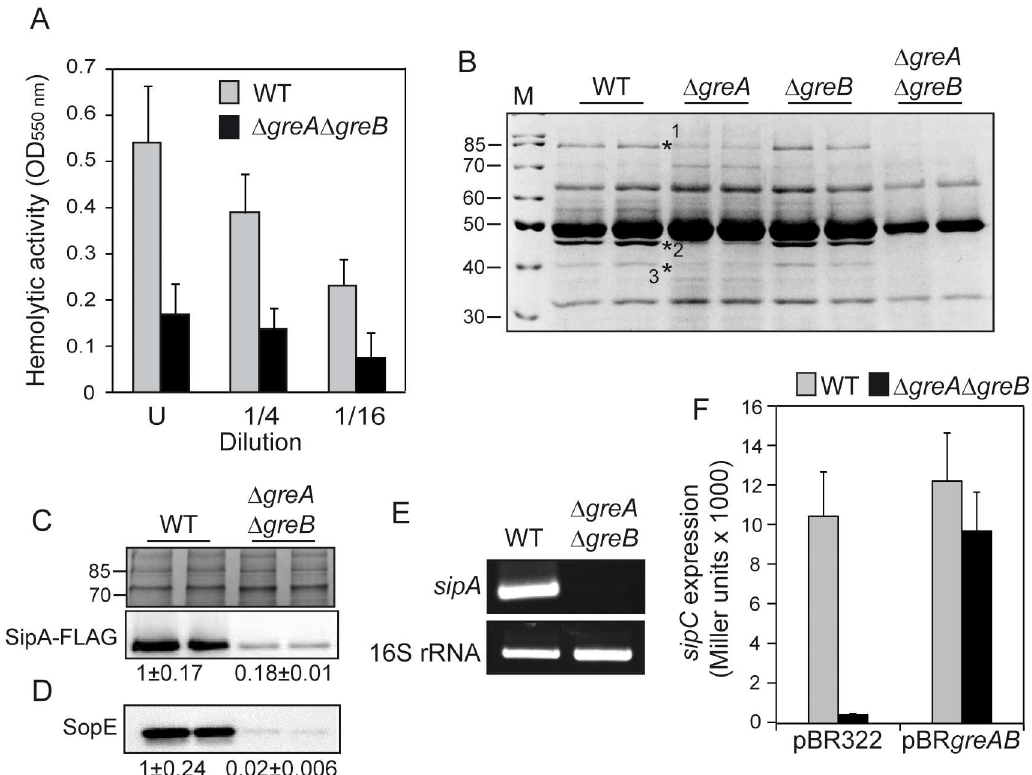
Fig 2. The Gre factors affect the expression of SPI-1 effector proteins. (A) Contact haemolysis assays with cell-free supernatants from cultures of the WT and Δ greA Δ greB derivative strains. The haemolyticactivity of LB bacterialcultures of WT and Δ greA Δ greB strains was monitored as an increasein the OD 550nm of the supernatantof a blood suspension with serial dilutionsof cell-free supernatants. U: undilutedsupernatant. Three independent bacterialcultures were tested. (B) Cell-free supernatants of two independent LB cultures of WT (SV5015)and its Δ greA , Δ greB and Δ greA Δ greB derivatives. Extracts were analyzedby Coomassie blue stained 12.5% SDS-PAGE. Lane M: molecular mass markers (size in kDa indicated). The bands labelledwere identifiedas SipA (1), FliD (2) and SipC (3) by LC-MS/ MS. (C) Immunodetection (lower panel)of the SPI-1 encodedSipA-FLAG protein in whole culture extracts from two independent cultures of WT and Δ greA Δ greB derivativestrains. The upper panel is a section of a Coomassie stainedgel as a loadingcontrol. (D) Immunodetection of SopE protein was performed in extracts from WT and Δ greA Δ greB strains obtained from cell-free supernatants of two independent LB cultures. (E) Semiquantitative RT-PCR of sipA in total RNA samplesfrom LB cultures of the WT (SV5015) and Δ greA Δ greB strains. 16S RNA was used as endogenouscontrol to confirm that equivalentquantities of templates were used. (F) sipC transcriptional expressionwas tested in cultures of WT and Δ greA Δ greB derivative strains carrying a chromosomal sipC :: lacZ fusion and either pBR322or pBR greAB .A bar shows the arithmetic mean of experimental results and the error bar indicatesthe standard deviationfrom three biological replicates.All cultures were grown in LB at 37˚C with vigorousshaking(200 rpm) up to an OD 600nm of 2.0.